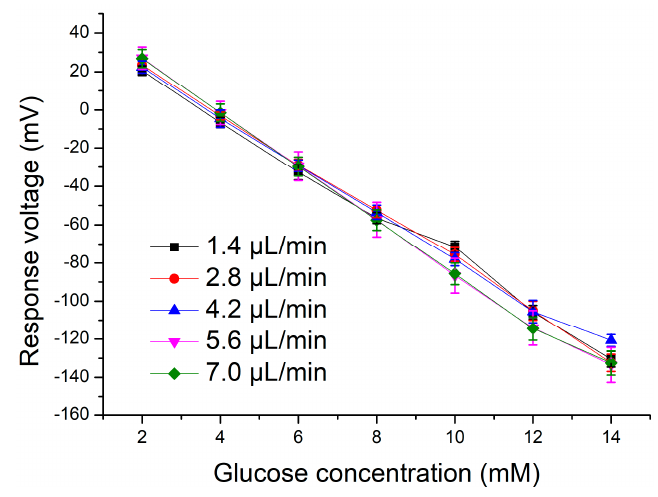
Figure 6. Response curves of the CZO sensor under different flow rates.